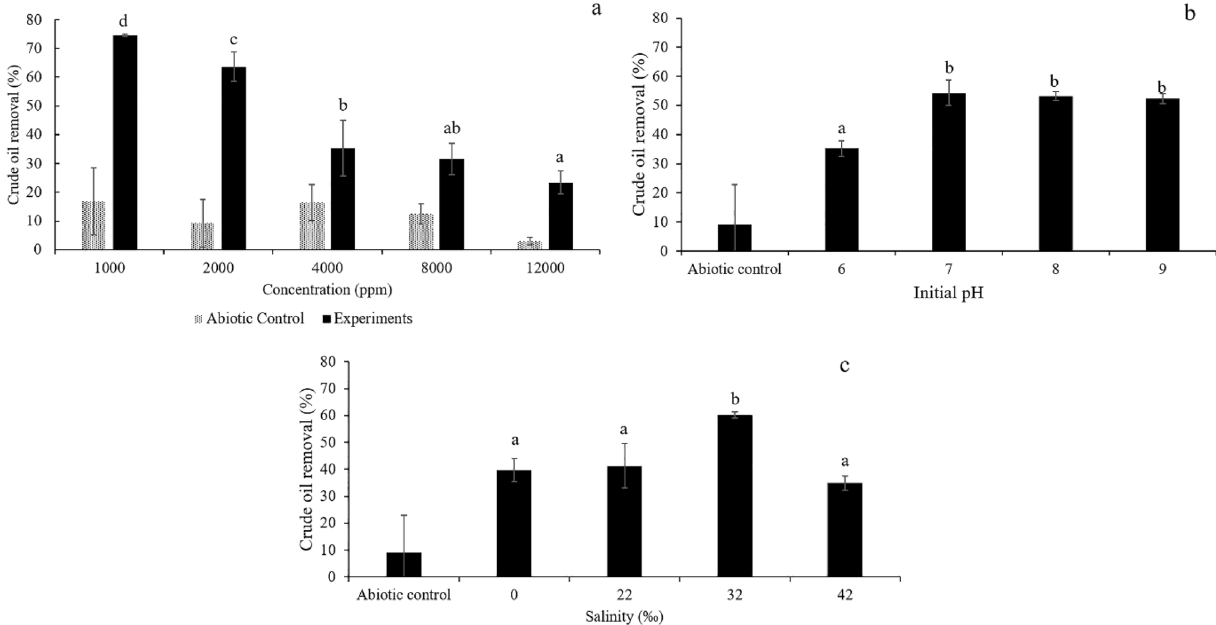
Figure 2. Effects of crude oil concentrations in the range of 1,000–12,000 ppm ( a ), initial pH ( b ) and salinity ( c ) on crude oil removal by immobilized Exiguobacterium sp. AO-11 cells were incubated at room temperature with continuous shaking at 200 rpm for 9 days. Data correspond to means of triplicate values, and error bars correspond to the standard deviation. The different letters represent significant differences at P ≤